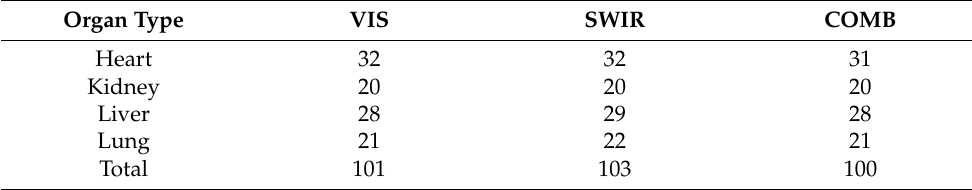
Table 1. Description and number of bovine and ovine parenchymatous organs used to develop automatic identification algorithms from visible (VIS) and short-wave infrared (SWIR) hyperspectral sensors and their combination (COMB) following removal of outliers. One heart from all spectra, one lung and one liver from VIS and COMB spectra, respectively, were removed.